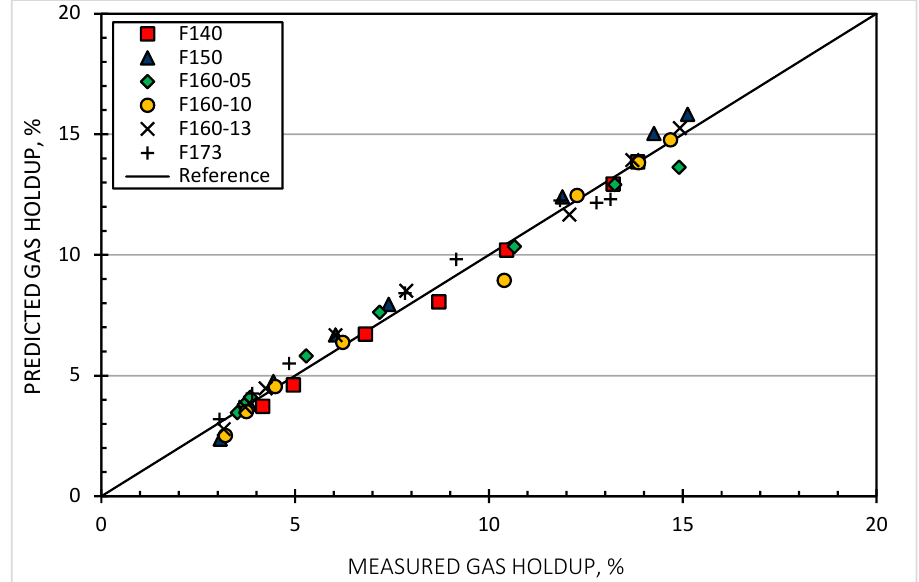
Figure 11. Predicted vs. measured gas holdup (Molerus model).